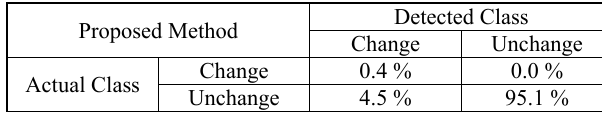
Table 5 . Results of the proposed method (MMS data).